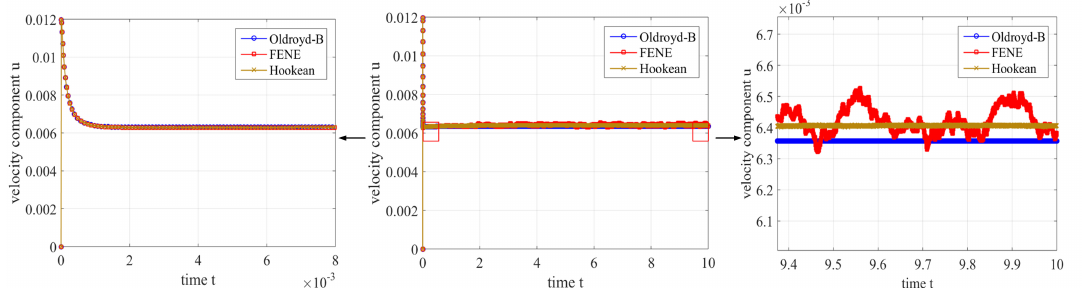
Figure 7. The evolution of horizontal velocity component u x for different models (Oldroyd-B model, Hooke model and FENE model) over time at point P 1 = ( 0.498,0.01 )